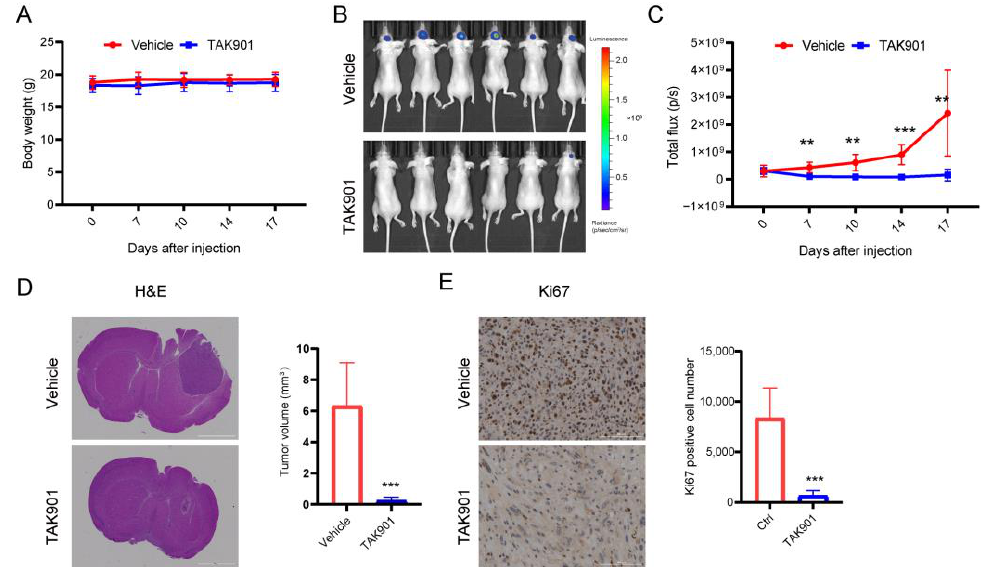
Figure 3. TAK901 inhibits tumor growth in vivo. U87MG-LUC cells were implanted into the brain of BALB/c nude mice. After 7 days, the tumors were established. The mice were randomized to the vehicle or the TAK901 treated group. n = 6. ( A ) Changes in the body weight of mice over time are shown. The body weight was measured twice per week after injection. ( B ) IVIS images were taken on day 17 after injection. ( C ) Quantification of the bioluminescence signal in ( B ). ( D ) Hematoxylin and eosin (H&E) staining of tumor sections. Mice were sacrificed on day 17. Brains were fixed and the tumor sections were stained by H&E. The tumor volume was quantified based on the H&E pictures. Scale bar, 2000 µ m. ( E ) Ki67 staining of tumor sections. The brains were fixed, the tumor sections were stained by Ki67, and the Ki67-positive cells were quantified. All analyses were performed using Gen5 software (BioTek, USA). Scale bar, 100 µ m. Significance was determined by unpaired and two-tailed Student ’ s t -test ( C , D , E ). ** p < 0.001, *** p < 0.001.